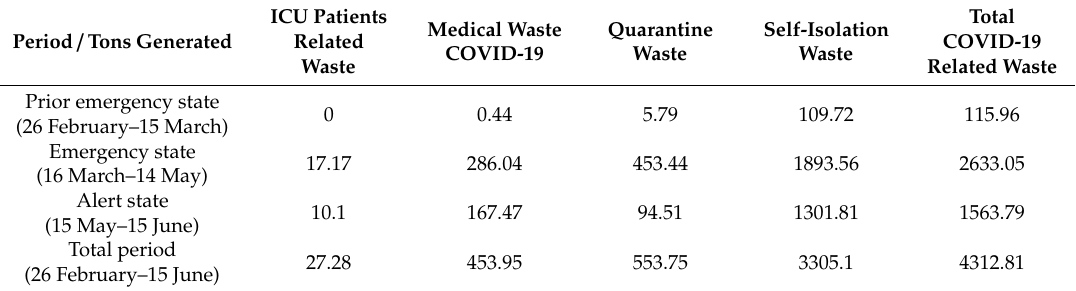
Table 1. COVID-19 waste flow at the national level from 26 February to 15 June 2020. Period / Tons